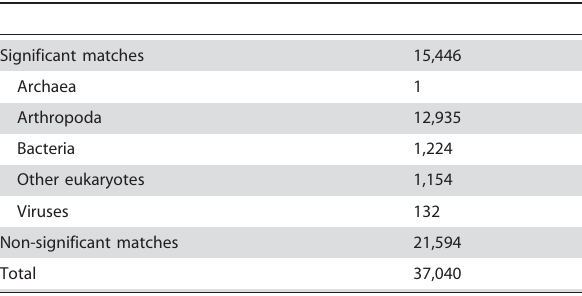
Table 2. Summary of BLASTX search of the Chilo suppressalis midgut sequences.